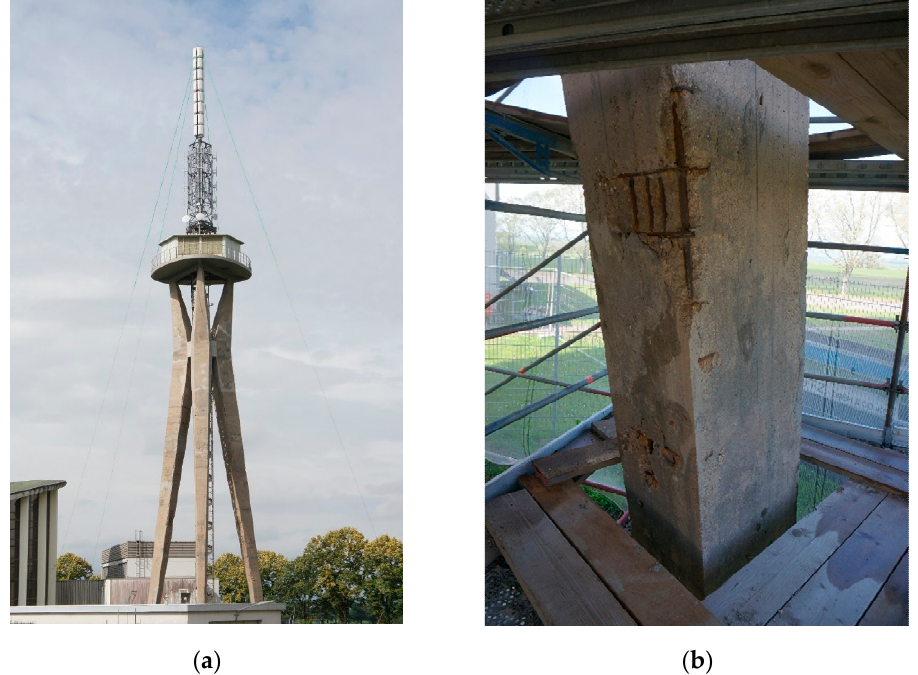
Figure 1. Transmission tower of the Berus Broadcasting Hall. ( a ) General view; ( b ) test application area near ground level (for accessibility for application and monitoring measures).